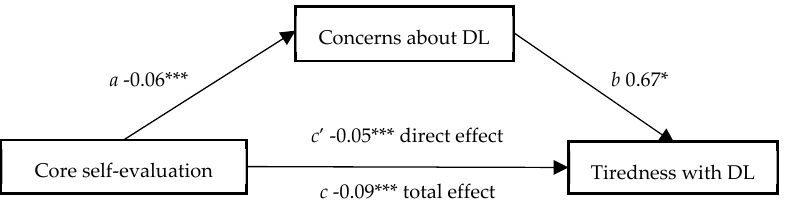
Figure 1. Regression coefficients for the relation between self-image (core self-evaluations) and tiredness with DL mediated by the concerns about DL. * p < 0.05, *** p < 0.001. Finally, the indirect effect ( c - c’ ) was − 0.04, 95% CI ( − 0.063, − 0.017). Since the